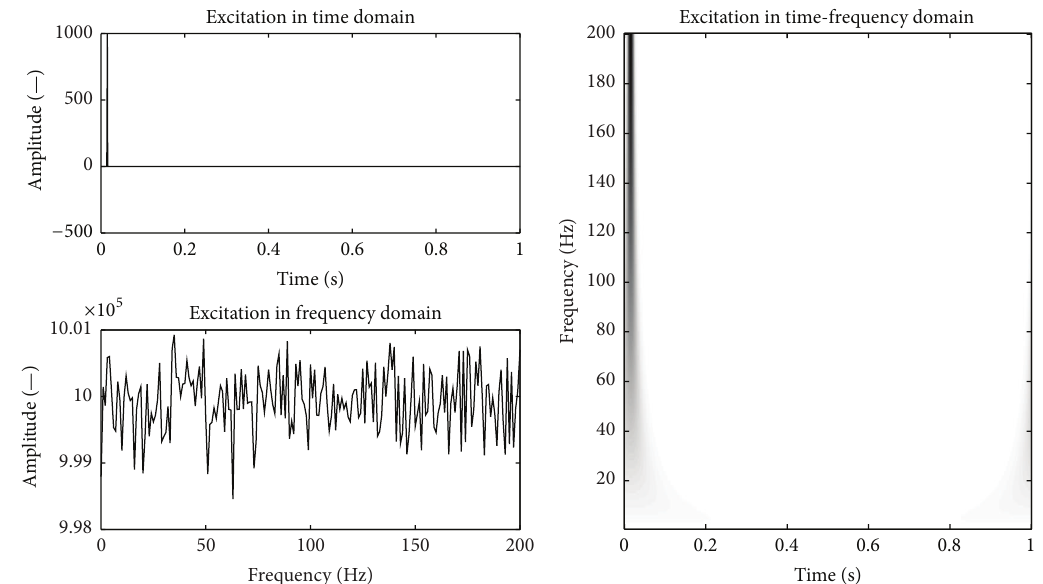
Figure 2: Impact excitation given in the time, frequency, and combined time-frequency